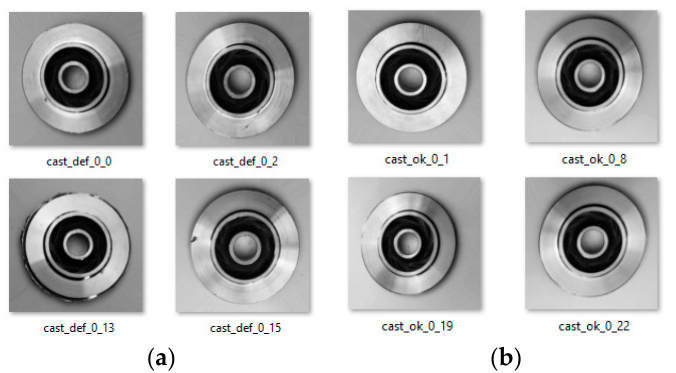
Figure 13. Casting product dataset. ( a ) Defective products; ( b ) Satisfactory products.